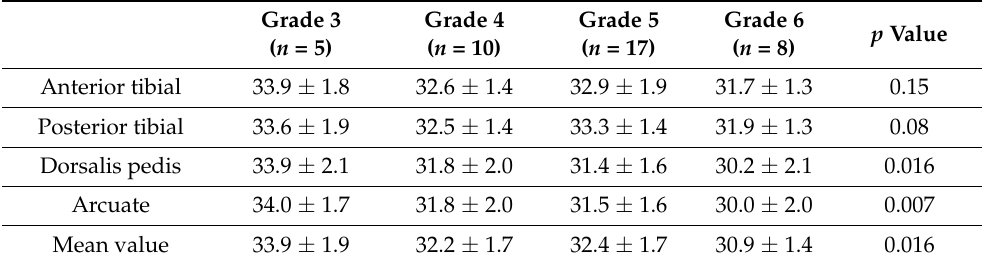
Table 3. The relationship between the clinical stage according to the Rutherford classification and the temperatures obtained from different foot locations.